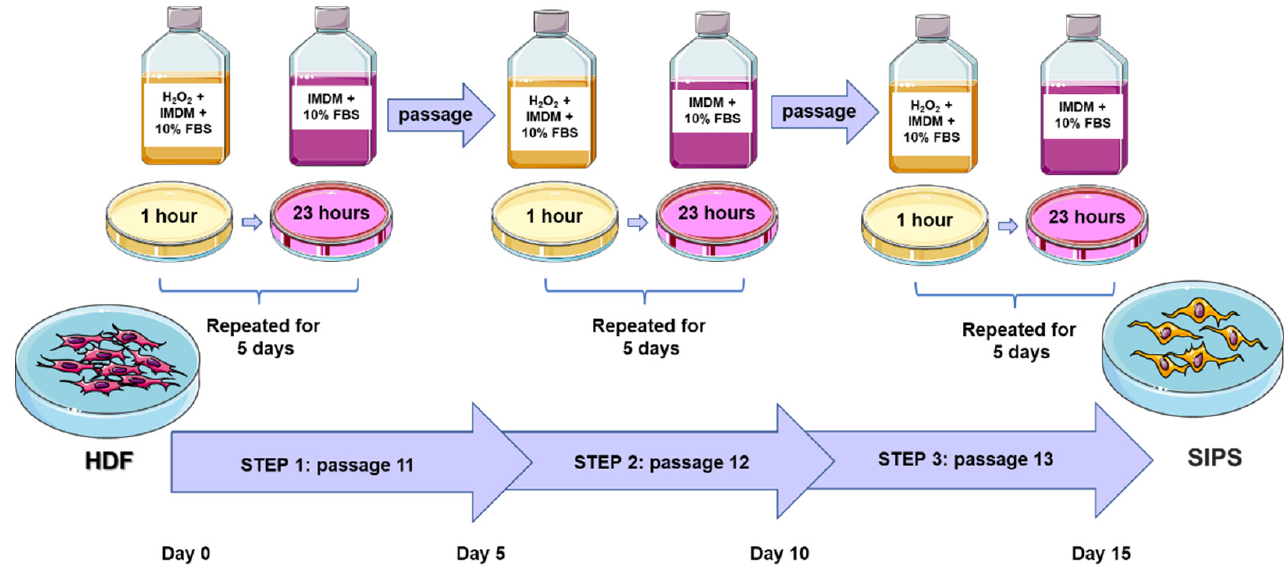
Figure 1. Three-step model of hydrogen peroxide stimulated premature cellular senescence. Culti- vated cells were treated daily with H 2 O 2 for one hour over a five-day period in each step. Each step started when cell confluency was approximately 70%. HDF, human dermal fibroblasts; SIPS, stress- induced premature senescence. This figure was created using images from Servier Medical Art Com- mons Attribution 3.0 Unported License (http://smart.servier.com accessed on 26 September 2020). The second senescence model focused on the fast induction of SIPS in skin fibrob- lasts (CCD-1064Sk and BJ-5ta cell lines). In this model, we also exposed cells to various concentrations of H 2 O 2 from 25 µ M to 350 µ M; however, fibroblasts were treated once with H 2 O 2 for one hour (Figure 2). Since fibroblasts are only treated with H 2 O 2 once, this method is called a one-step model. In addition, H 2 O 2 was dissolved in the PBS to eliminate the protective effect of the cell culture medium with FBS supplementation and induce a stress-like calorie restriction condition. PBS did not show adverse effects on cell cultures within one hour (data not shown) and was used in the subsequent experiments as a solvent for H 2 O 2 . We will compare these two senescence models and the effects of various concentrations of H 2 O 2 in the SIPS developmental